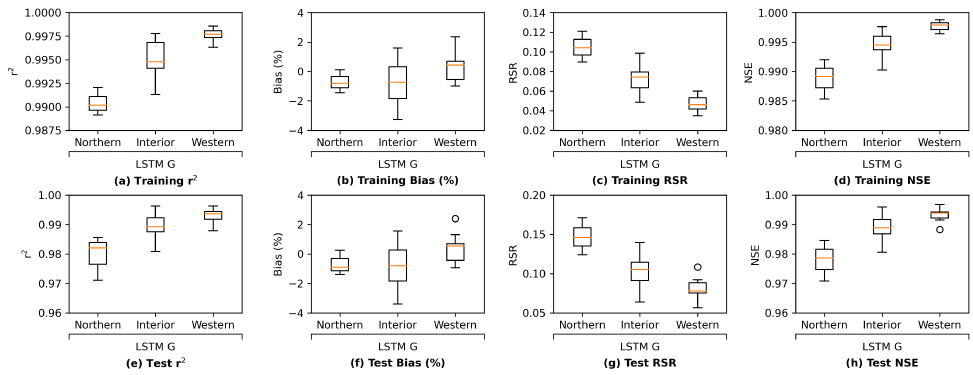
Figure 13. Box and whisker plots of four types of metrics consisting of r 2 , percent bias, RSR, and NSE during the training (panels ( a – d )) and test (panels ( e – h )) phases of the originally proposed MLP and LSTM models as well as two additional models (GRU and